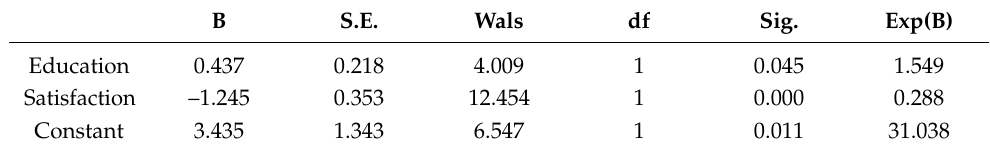
Table 4. Estimation results of factors influencing farmers’ cognition to environmental